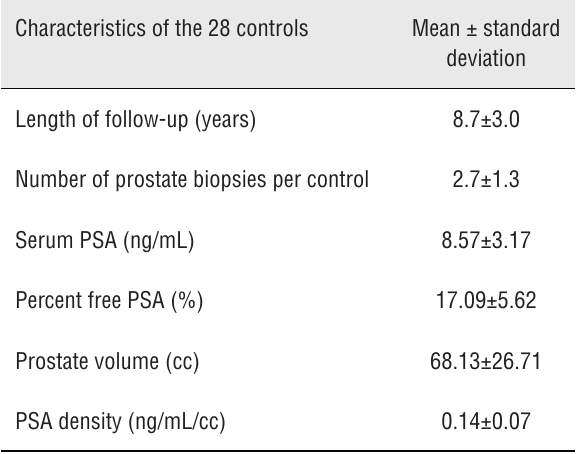
Table 1 - Characteristics of the 28 controls included in the